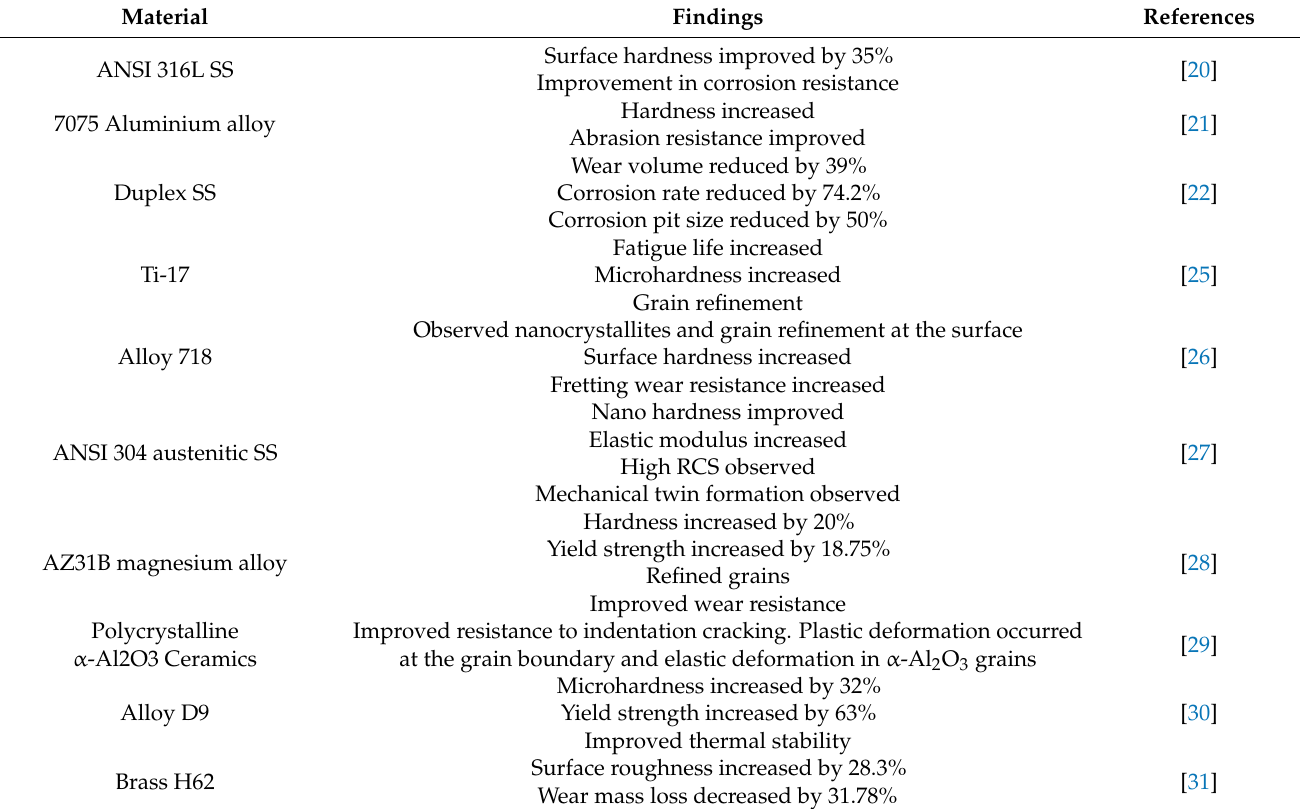
Table 3. Typical process parameters of LSP and findings from the literature. Material